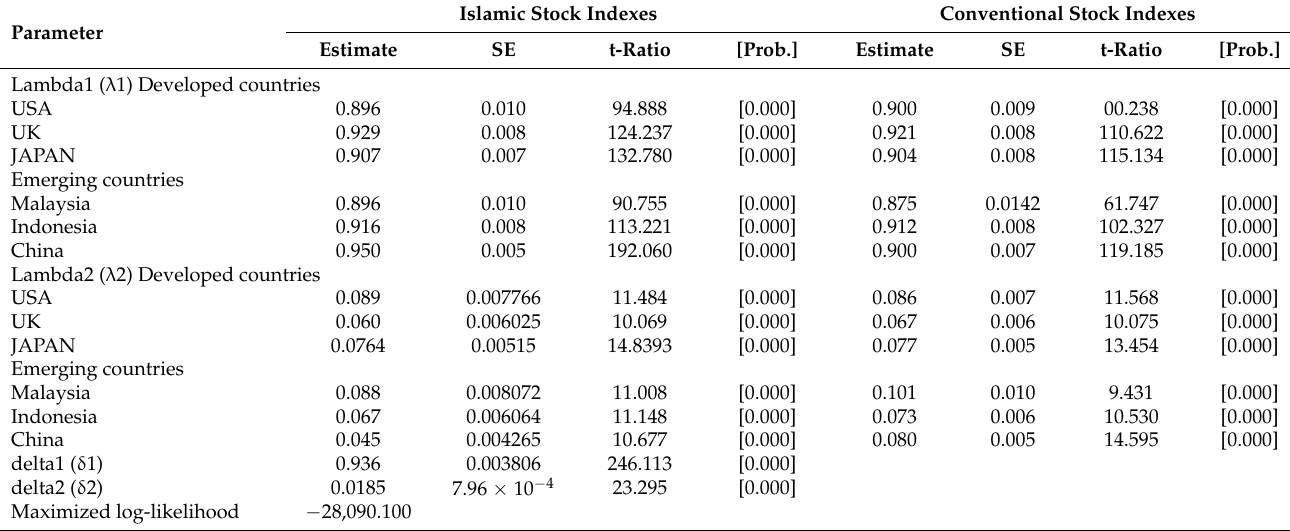
Table 3. Normal DCC model for maximum likelihood estimation.